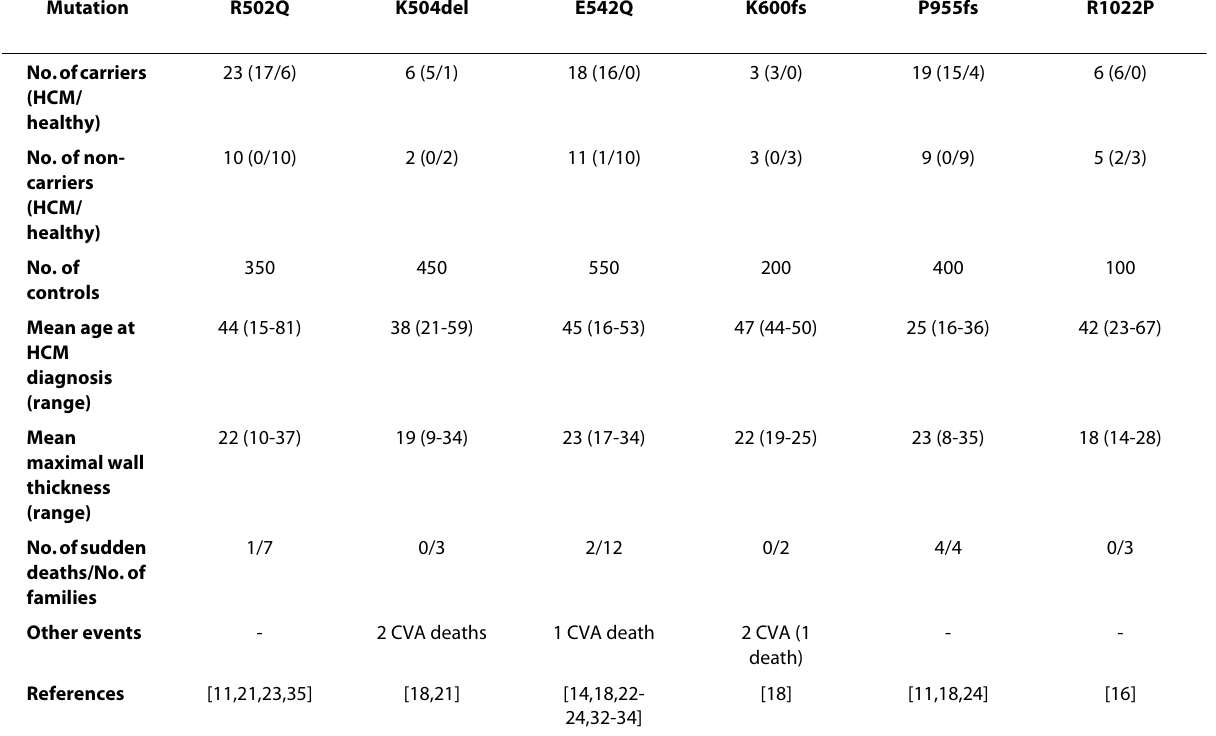
Table 3: Genotype-phenotype correlation in previously described mutations.